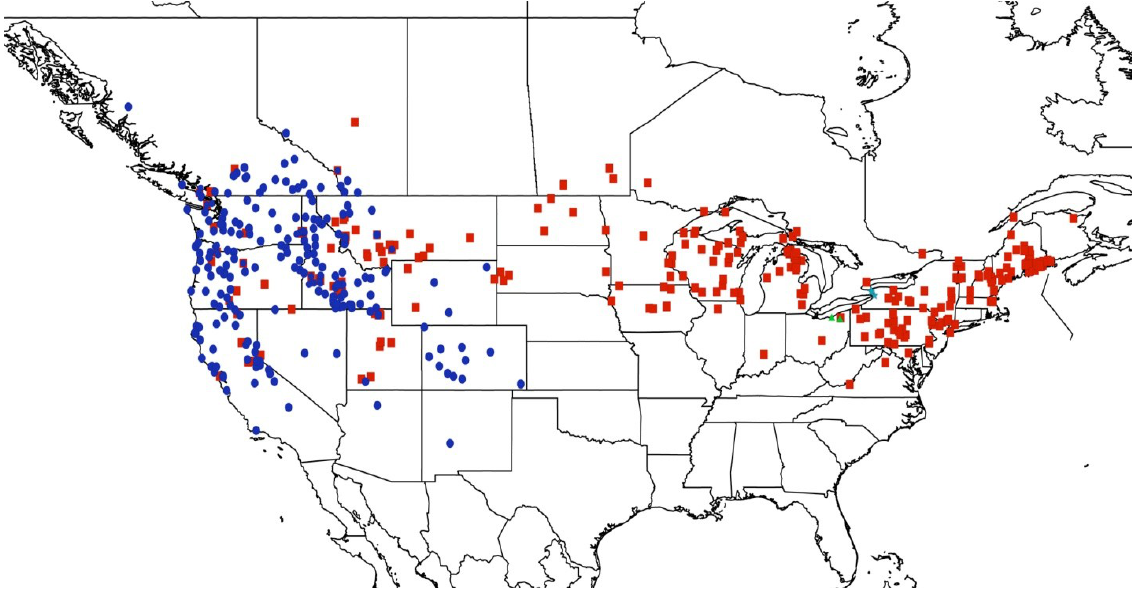
Figure 47. Distribution of Okanagana rimosa rimosa (red squares), O. rimosa ohioensis (green triangles), O. noveboracensis (light blue stars) and O. occidentalis (blue circles).